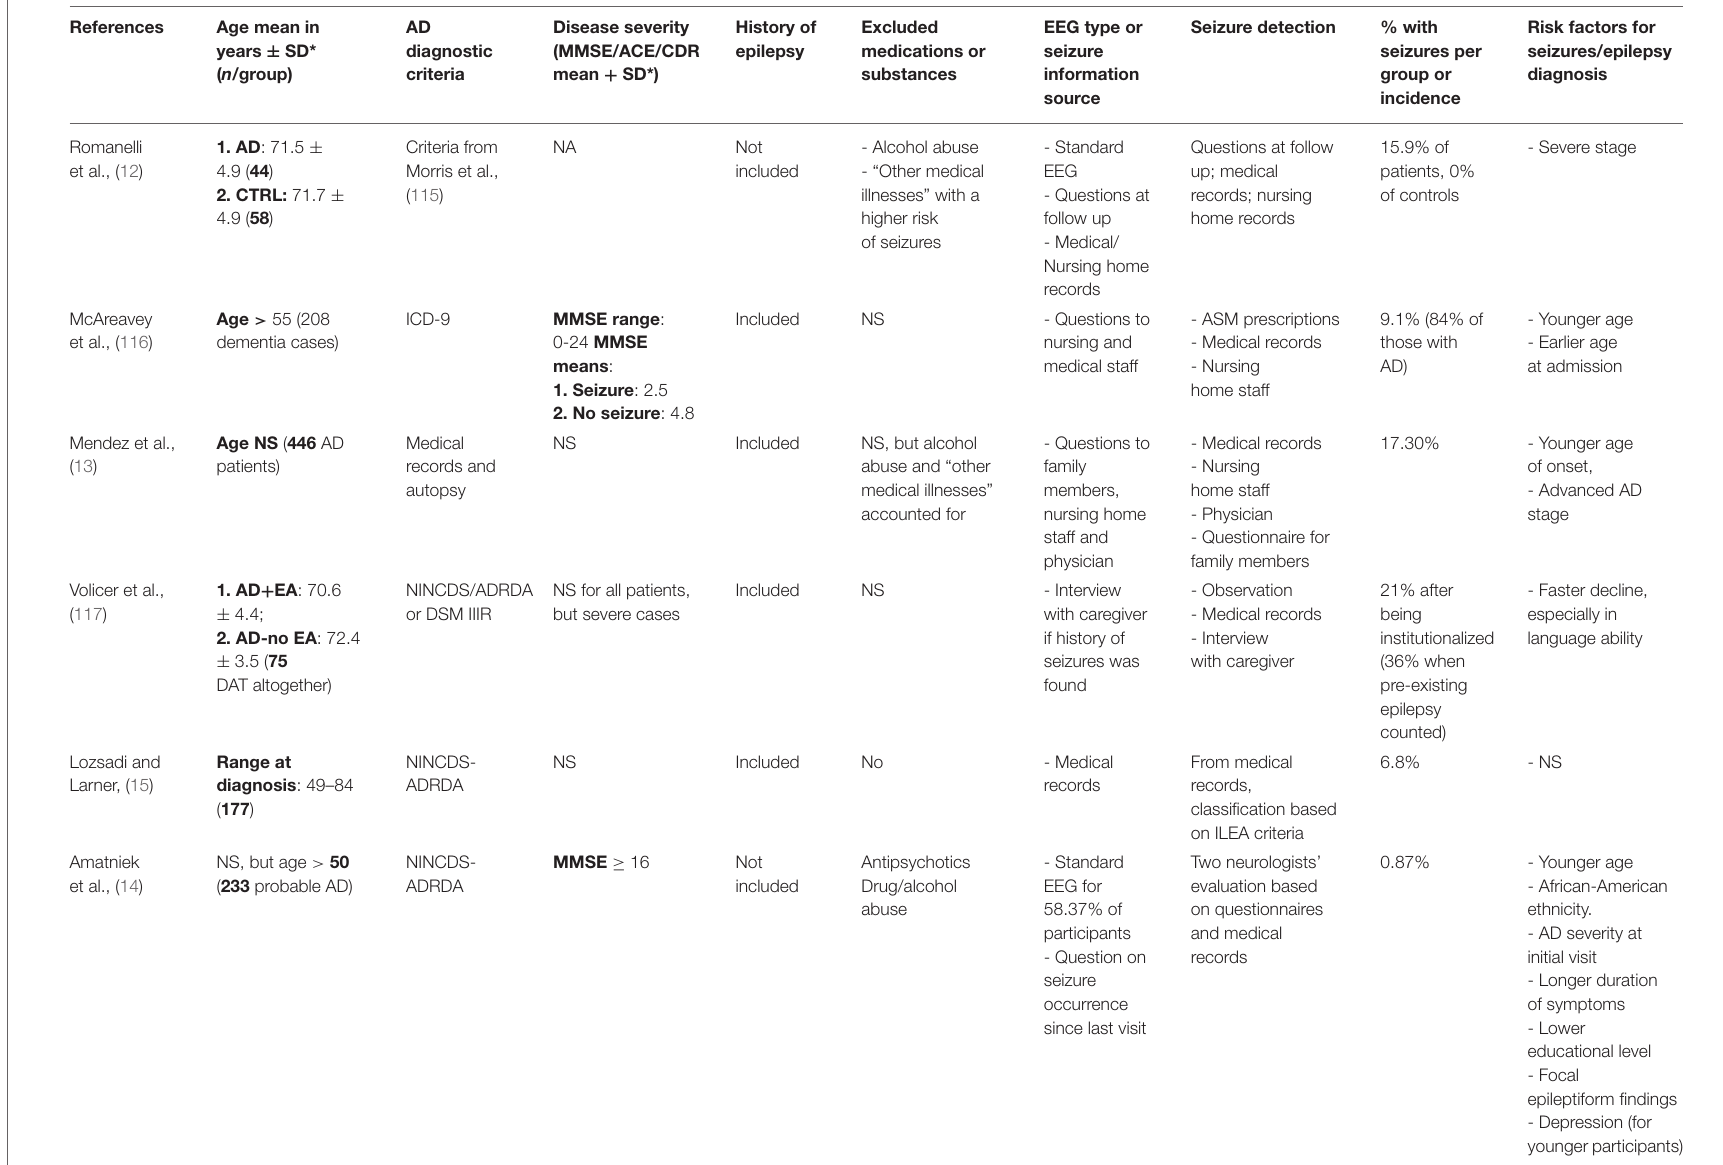
TABLE 2 | Main inclusion criteria and results of clinical studies that explore the prevalence of seizures in AD